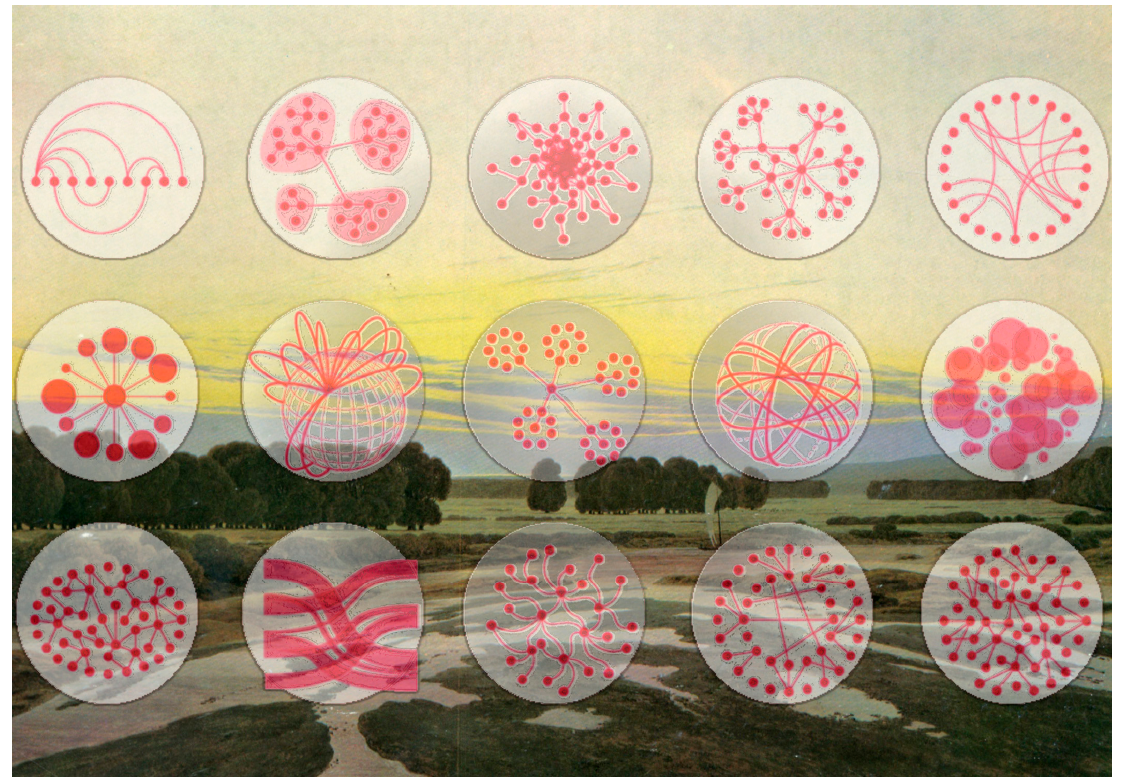
Figure 4. The category of an object is a network of information; these are 15 types of network